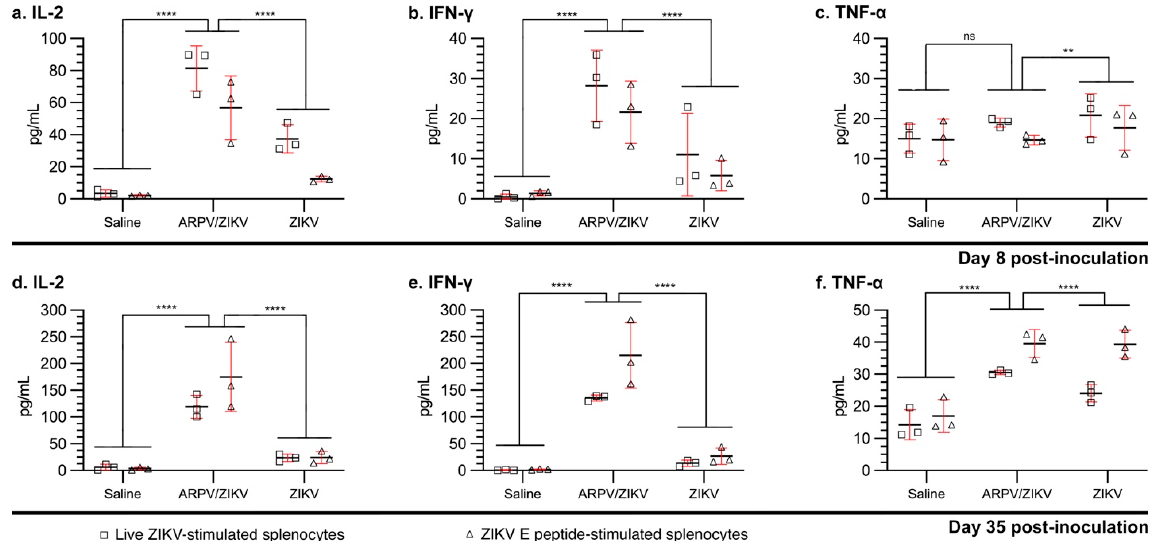
Figure 8. ARPV/ZIKV vaccination provides protection mediated by production of key cytokines related to antiviral response. Four-week-old C57BL/6 mice were inoculated s.c. with either saline, ARPV/ZIKV, or ZIKV. Splenocytes were harvested from animals (n = 3) at either ( a – c ) 8 days post-infection (dpi) or ( d – f ) 35 dpi and cultured in triplicate for in vitro stimulation with either live ZIKV (squares) or ZIKV E peptide mix (triangles). Cytokine levels in cell culture supernatant were determined by bead-based Luminex immunoassay. Cultured splenocytes derived from ARPV/ZIKV- vaccinated mice produced high levels of key antiviral cytokines ( a , d ) IL-2 and ( b , e ) IFN- γ at both 8 and 35 dpi and ( f ) TNF- α at 35 dpi after in vitro stimulation with ZIKV antigens. Data points represent physiological replicate values, horizontal bars indicate mean values and error bars indicate SD of the mean. Significance was determined by two-way ANOVA with ad hoc Tukey’s test. Comparisons shown were made only between the various groups stimulated with either live ZIKV, or between the various groups stimulated with ZIKV E peptide. Unless otherwise marked, asterisks indicate significance compared to saline-inoculated negative controls: not significant (ns), p ≤ 0.002 (**) and p ≤ 0.0001 (****). 4. Discussion We explored a variety of in vitro and in vivo measures to characterize the safety profile of ARPV/ZIKV relative to its ARPV backbone and ZIKV. A key feature of ARPV/ZIKV is its safety due to the inherent mammalian host-restriction imposed by ARPV. Our in vitro RT-qPCR and protein expression studies demonstrated the absence of detectable ARPV/ZIKV replication in mammalian cell lines that are highly susceptible to arbovirus— specifically ZIKV—infection. Our results suggest that ARPV/ZIKV is fundamentally mammalian host-restricted, likely before the point of viral RNA amplification (Figure S3). The absence of detectable replication in mammalian cells is likely not a temperature- dependent effect, as previous studies show ARPV (i.e., vaccine backbone) was unable to replicate in mammalian cells at 29 °C [32]. Furthermore, ARPV/ZIKV was blindly serially passaged through immune-compromised mammalian cells to facilitate adaptation for replication, but there was no evidence of this gain of function for ARPV or ARPV/ZIKV, as quantified by RT-qPCR (Figure S4). Further work should be conducted to confirm the stability of the chimera’s host restriction over multiple passages in human and other vertebrate cell lines. Given the strong evidence for a complete replication defect of ARPV and ARPV/ZIKV, the likelihood of this adaptation to develop is extremely low. ARPV/ZIKV also demonstrates exceptional safety in murine models, yielding no detectible adverse health effects after immunization. Our hemogram studies showed that administration of the ARPV/ZIKV vaccine was not associated with significant inflammation (Table S1). This study did show a significant decrease in the mean corpuscular volume of erythrocytes in circulation (microcytosis) of mice exposed to the